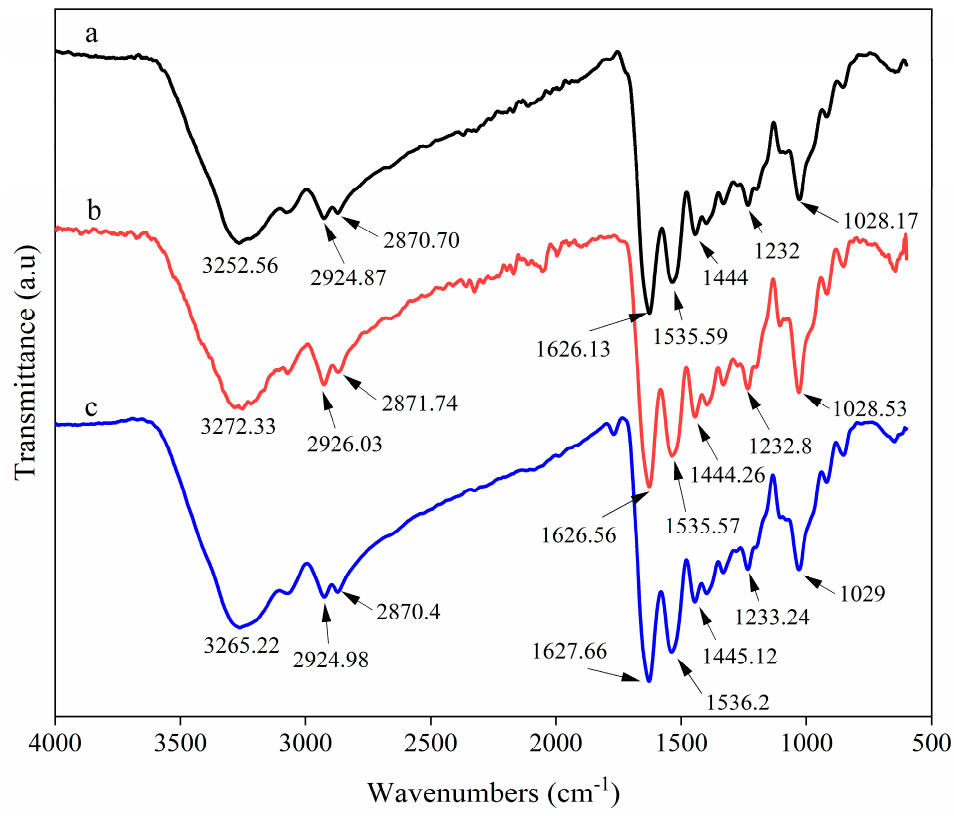
Figure 2. The FT-IR spectra of G/ChNF ( a ), G/ChNF/BA ( b ), and G/ChNF/SPA ( c ) smart indicators.